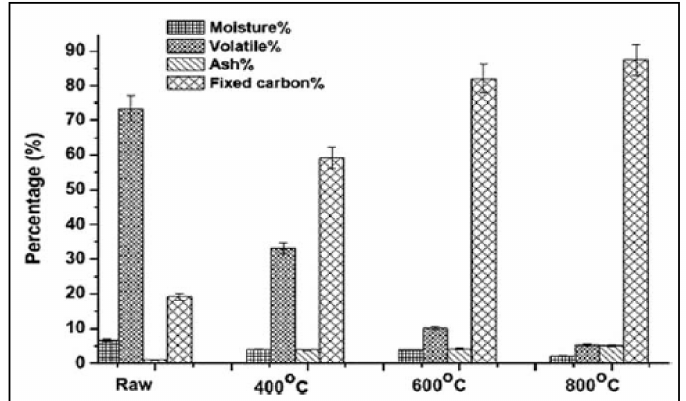
Figure 16. Proximate analysis of wood apple shell powder [86].